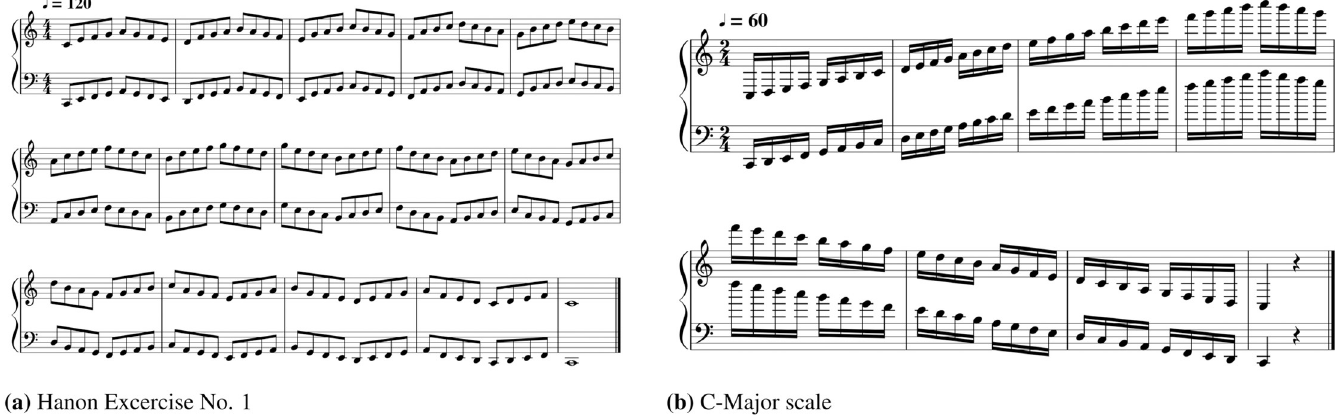
Fig 1. Musical excerpts: The music scores of the two excerpts selected for this study. (a) Hanon Exercise No. 1; (b) C-Major scale.